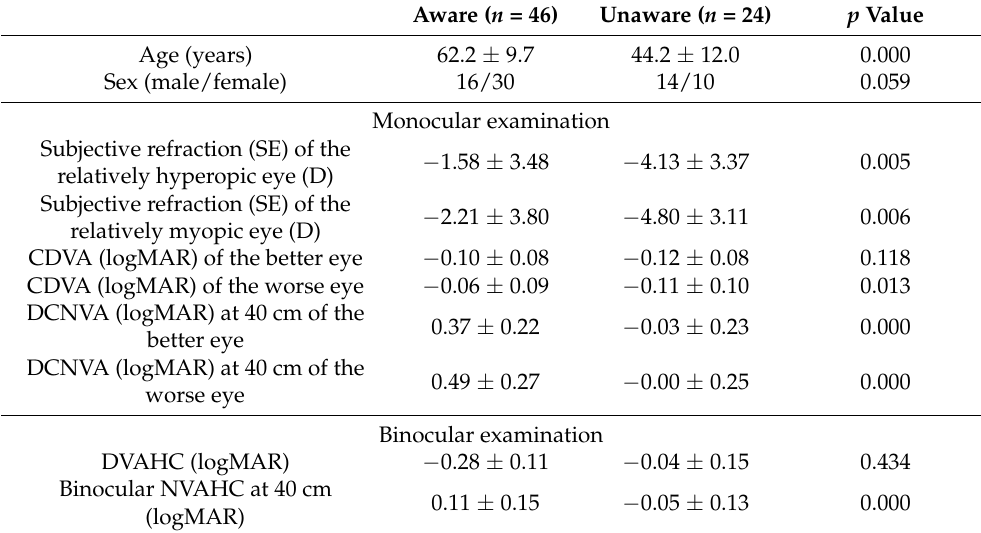
Table 1. Comparisons of the clinical data between the awareness and absence of awareness of